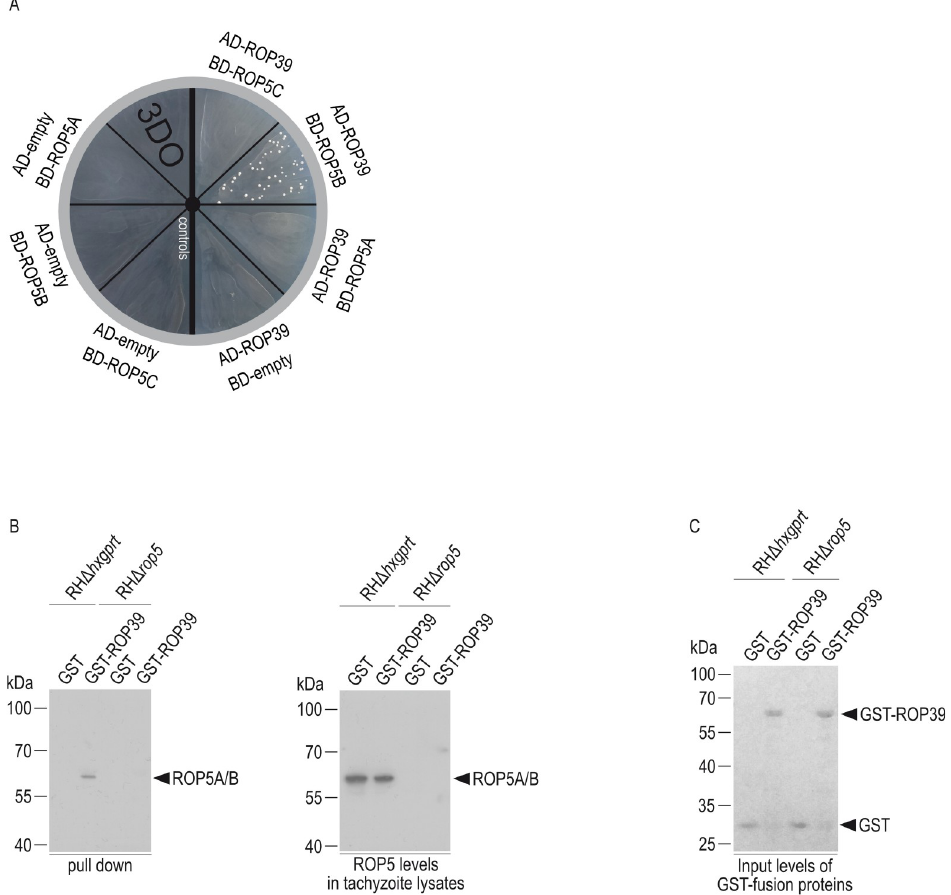
Fig 1. T . gondii ROP39 is directly associated with ROP5B. A, Yeast Two-Hybrid. T . gondii ROP39 directly binds to ROP5B but not ROP5A and ROP5C. Proteins were expressed either as fusion to the Gal4 transcriptional activation (AD) or DNA-binding (BD) domain. Colony growth under 3DO conditions demonstrates protein:protein-interaction. The bold black line indicates assembly of two different plates. B, Pull-down of ROP5A and/or ROP5B (the antibody used for detection does not allow detection of ROP5C and cannot discriminate between ROP5A and B [43]) by mature GST-ROP39 from RH Δ hxgprt tachyzoite detergent lysates. RH Δ rop5 tachyzoite detergent lysates have been included as control (left hand panel). ROP5 levels in tachyzoite detergent lysates used in the pull-down (right hand panel). C, Ponceau staining of the membrane used in B shows the input of GST and GST-fusion proteins used in the pull-down.